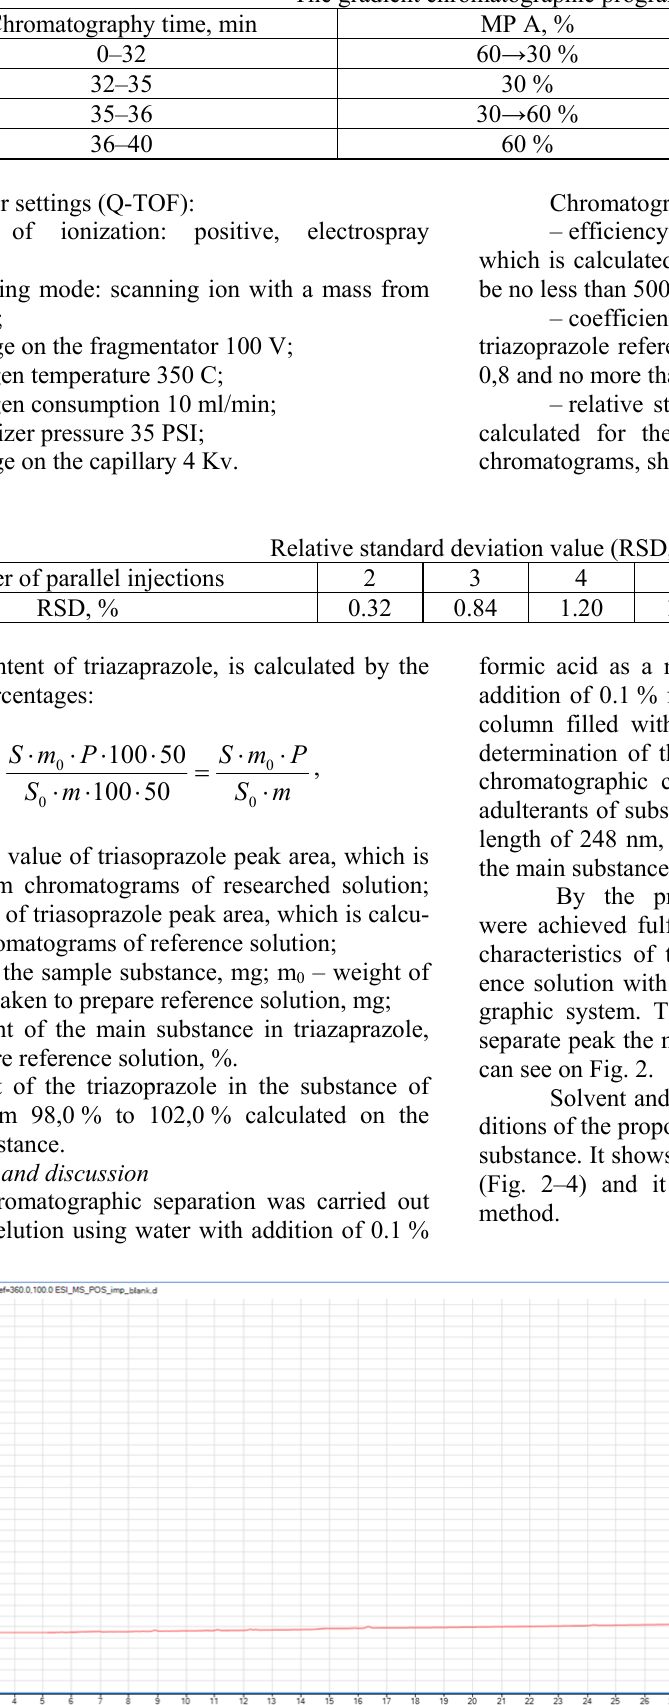
Fig. 2. The chromatogram of solvent